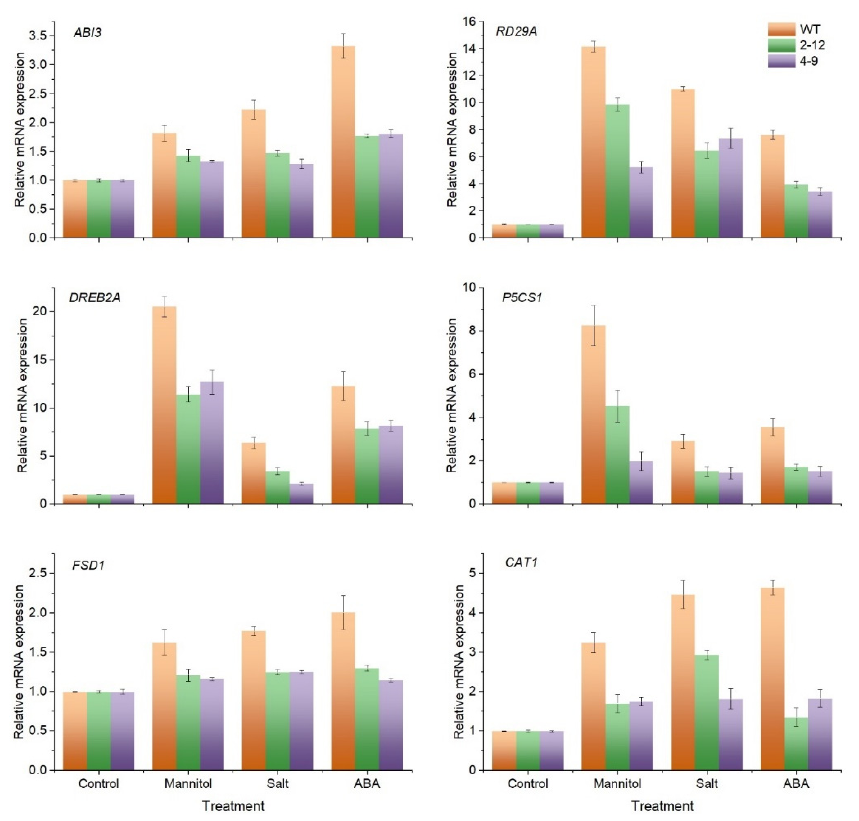
Figure 7. Relative expression of stress/ABA-responsive genes in SlBAG9 -overexpressing Arabidopsis exposed to mannitol, NaCl, and ABA stress. The seven-day-old Arabidopsis plantlets of wild-type, 2–12, and 4–9 were transferred to 1/2 MS containing 0, 300 mM mannitol, 175 mM NaCl, and 1.5 µM ABA for three days. Total RNAs were extracted, and qRT-PCR analyses were performed. Error bars indicate the SD of three replicated experiments.